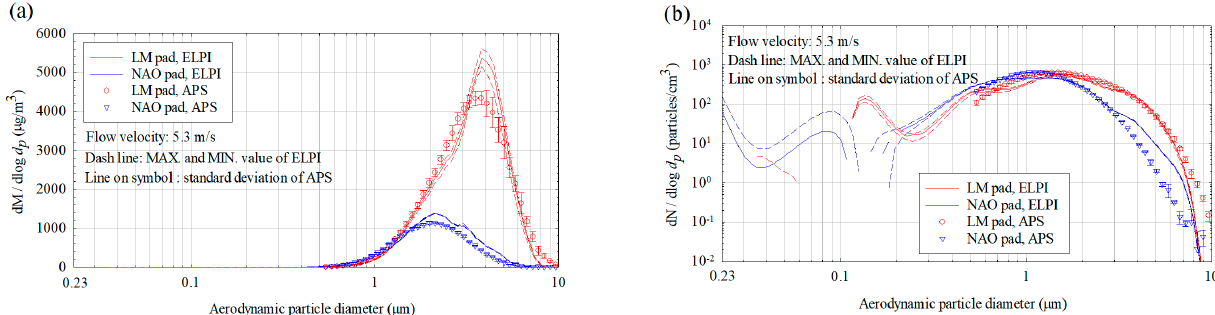
Figure 5. BWP size distributions of ( a ) mass concentration and ( b ) number concentration when using LM and NAO pads.